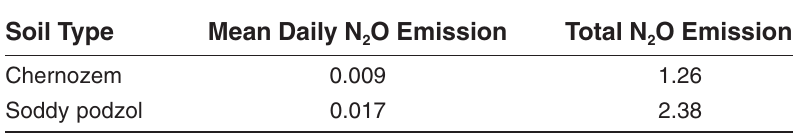
O from Nitric Fertilizers 2 O-N, Percentage of Fertilizer N 2